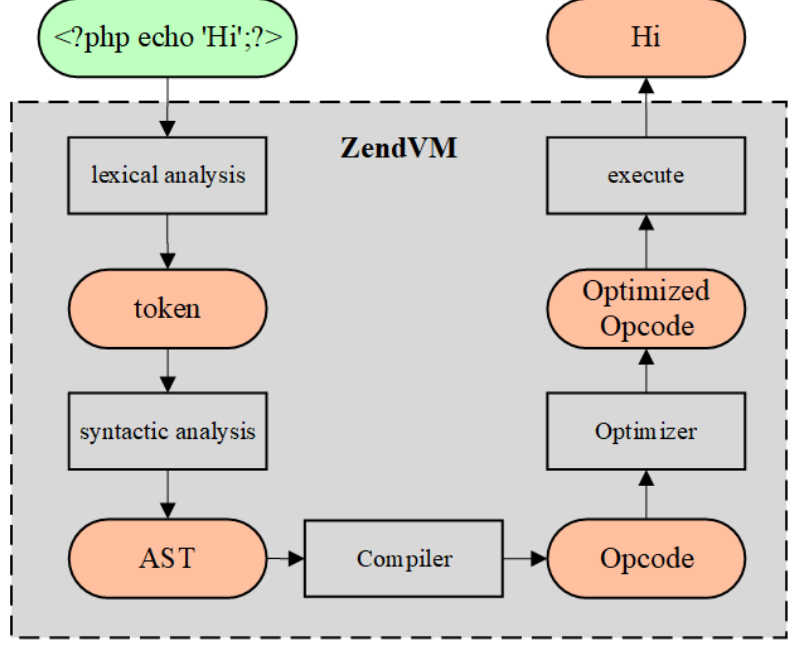
Figure 1. The workflow of the